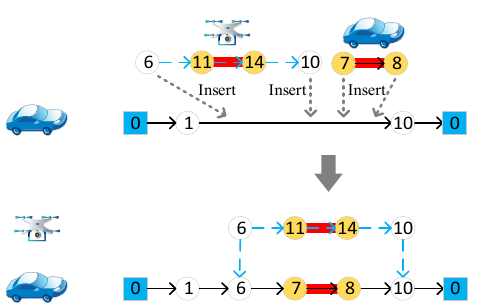
Figure 11. The repair operator. Different numbers in the figure represent different nodes of the road network.